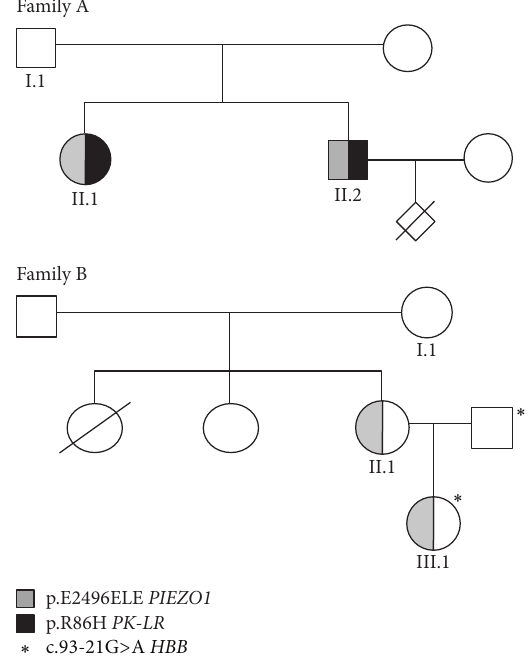
Figure 1: Genealogical trees of the reported